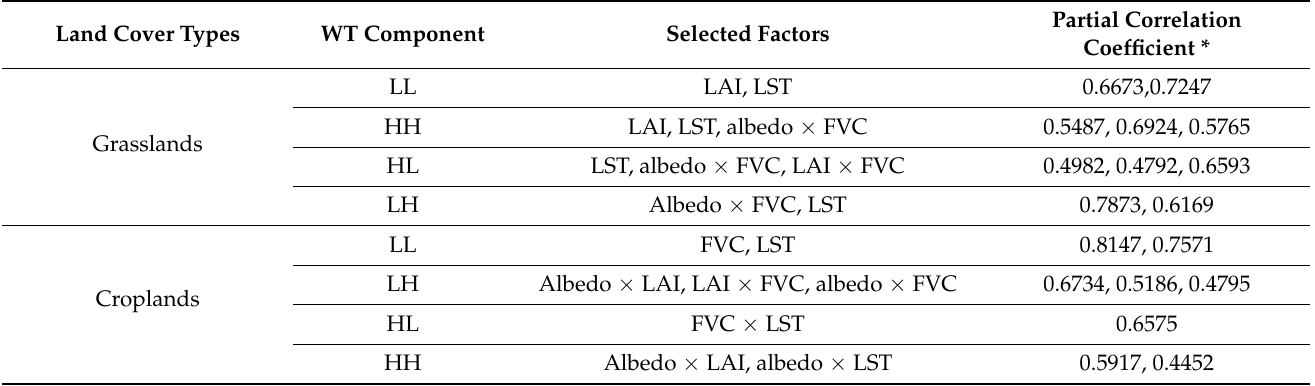
Figure A1. Frequency distributions in the probability density of the final selected fitting factors, with relatively good consistency with the frequency distribution of the original RFSM in the four WT components (LL, LH, HL, HH) over grassland. Table A1. Summary of the final selected factors by MFS for the four land cover types over the